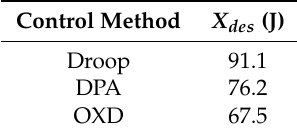
Table 5. Comparison of the exergy destruction X des for the different control